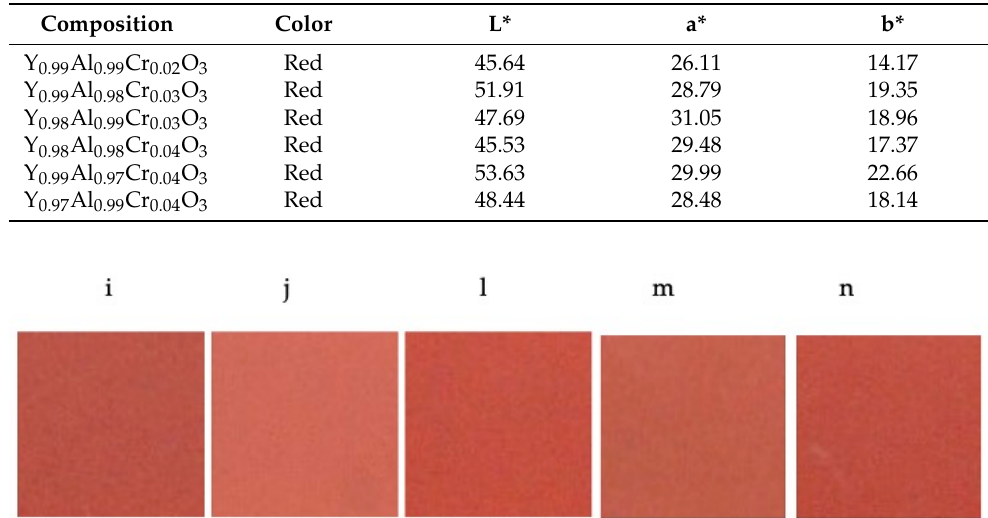
Figure 9. Color development of glazed tiles with fired pigment 1500 °C/6 h with 5% w / w CaF 2 addi-